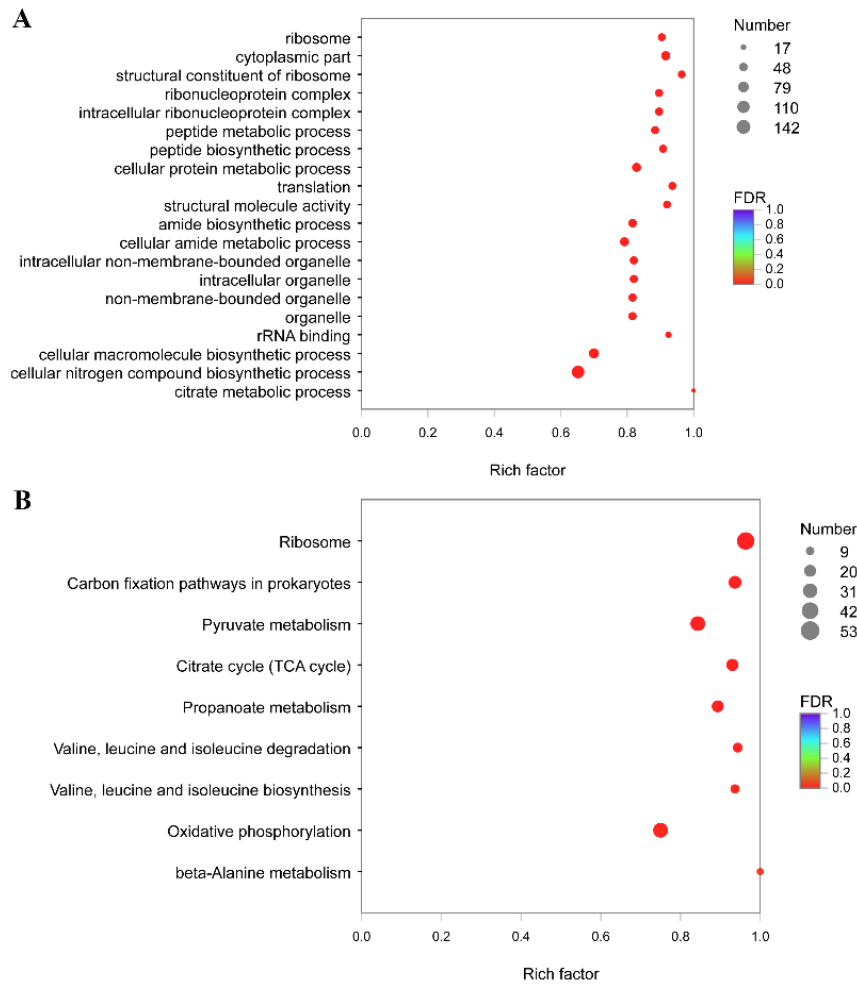
Figure 5. Analysis of differentially expressed genes between 18 and 37 °C. ( A ) GO terms of DEGs between 18 and 37 °C were classified based on their molecular functions, involvement of biological processes and cellular components. The size of the dot indicates the number of genes/transcripts in this GO term, and the color of the dot corresponds to different FDR ranges. ( B ) KEGG enrichment of differentially expressed genes between 18 and 37 °C. The size of the dot indicates the number of genes in this pathway, and the color of the dot corresponds to different q ‐ value ranges.